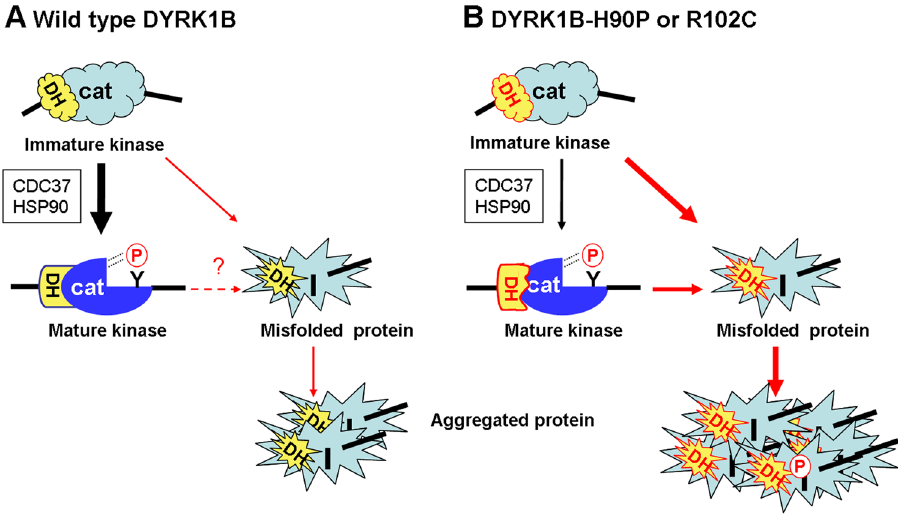
Figure 9. Proposed effect of the pathogenic mutations on the balance between DYRK1B maturation and misfolding. ( A ) DYRKs acquire the mature, active conformation of the catalytic domain by autophosphorylation (indicated by the circled P) of a tyrosine residue ( Y ) in the activation segment. In its folded state, the DH box forms interactions with the N-terminal lobe of the kinase domain 16 . The phosphorylated tyrosine (pY273 in DYRK1B) stabilizes the active conformation of the catalytic domain 16 . We propose that the unphosphorylated state is prone to misfolding and subsequent aggregate formation. The CDC37/HSP90 chaperone binds conformationally instable kinase domains and supports maturation. ( B ) We propose that the mutations in the DH box of DYRK1B perturb the maturation of the catalytic domain, which leads to enhanced misfolding and aggregation of unphosphorylated protein. The malfunction of the DH box also reduces the conformational stability of the mature protein, as evidenced by the presence of pY273 in the detergent-insoluble fraction and binding to